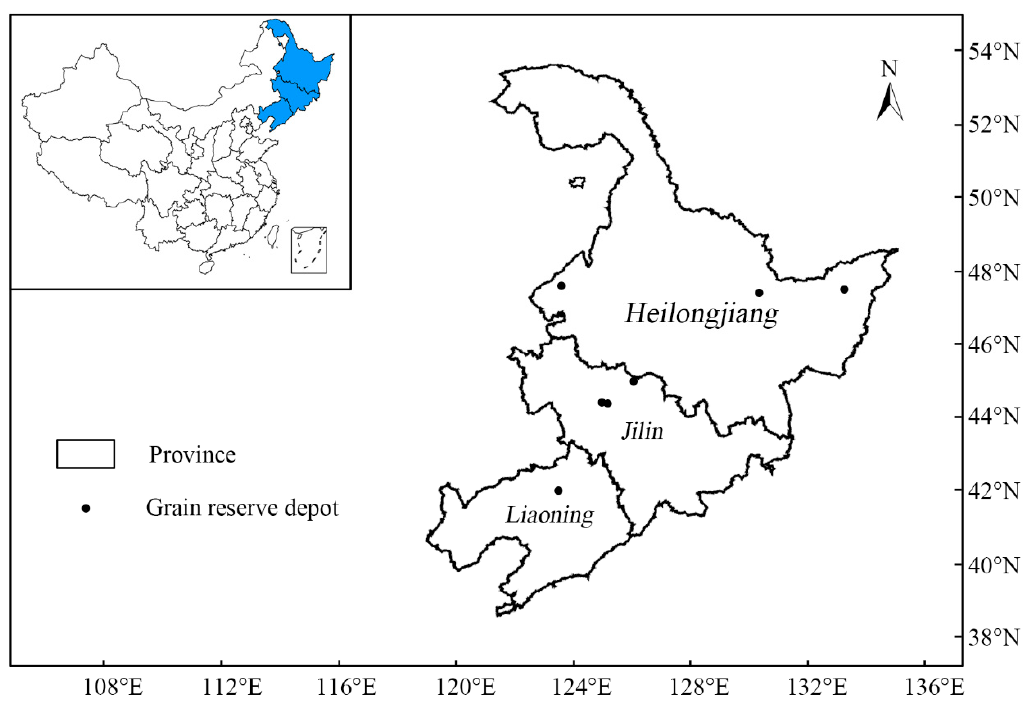
Figure 1. Locations of selected grain reserve depot in northeast China.